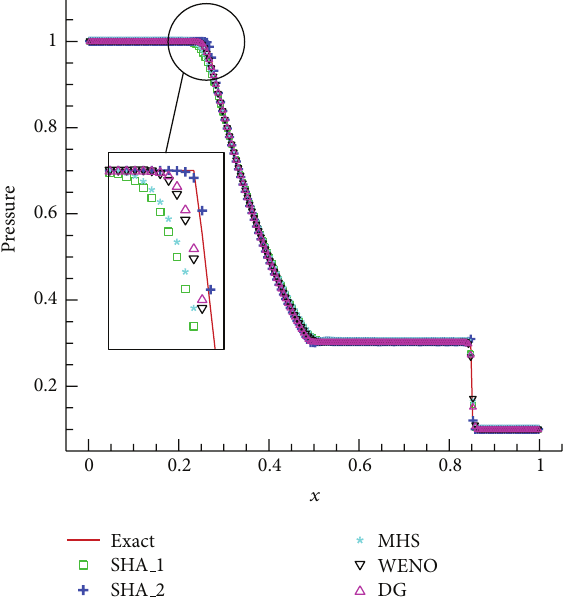
Figure 13: Density comparison of schemes at time 0.2 units for Sod’s tube problem.